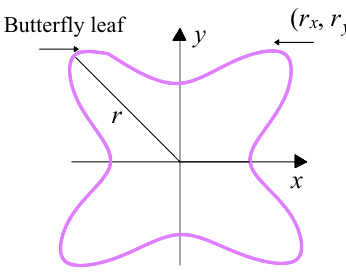
Figure 12. Meaning of butterfly boundary.